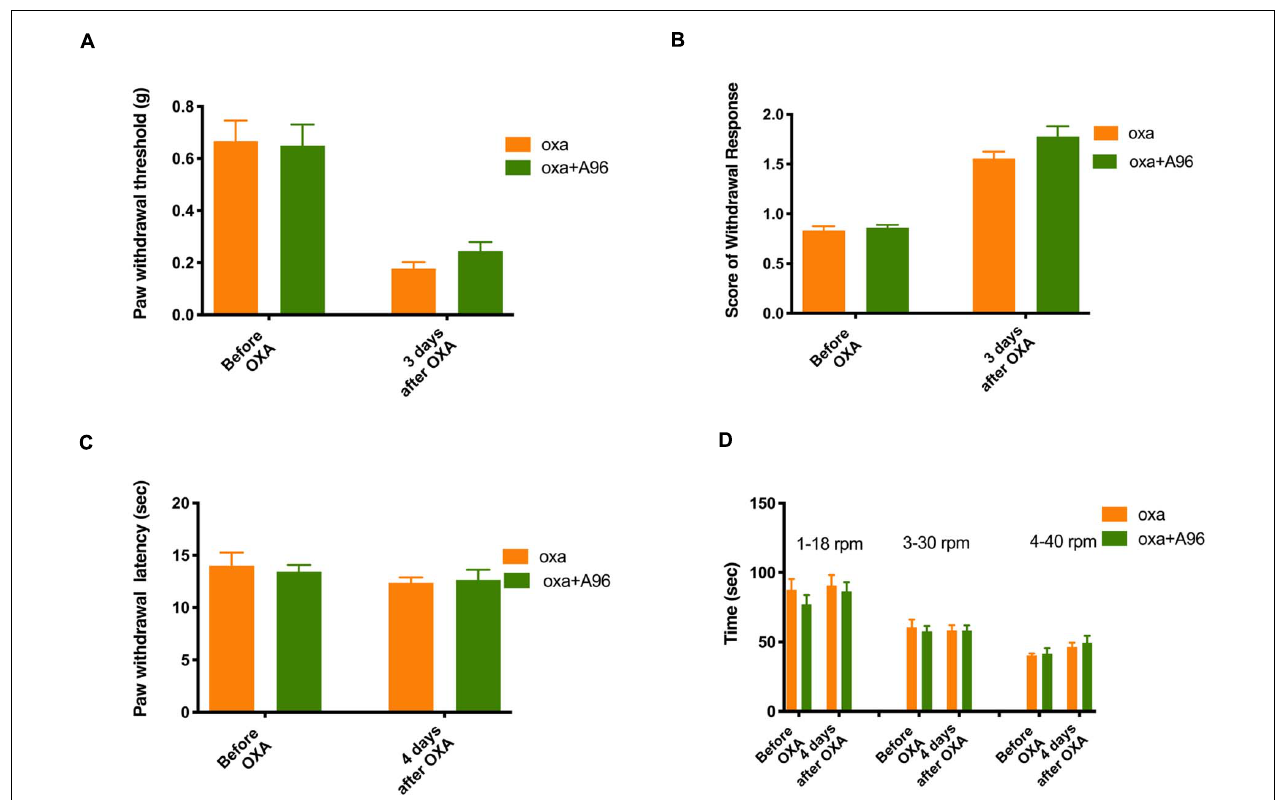
FIGURE 6 | Effects of A-967079 on the sensory and motor behaviors following oxaliplatin treatment. The administration of oxaliplatin, the schedule for A-967079 (A-96, 100 mg/kg, po) treatment (same to the Retigabine and TC-I treatment), the testing schedule for different types of behaviors were described in the Legend of Figure 3 . (A) Paw withdrawal threshold to Von-Frey filament; (B) Score of withdrawal response to acetone; (C) Paw withdrawal latency to radiant heat; and (D) Time stayed on rod at different speeds in rotarod tests ( n = 6 for all